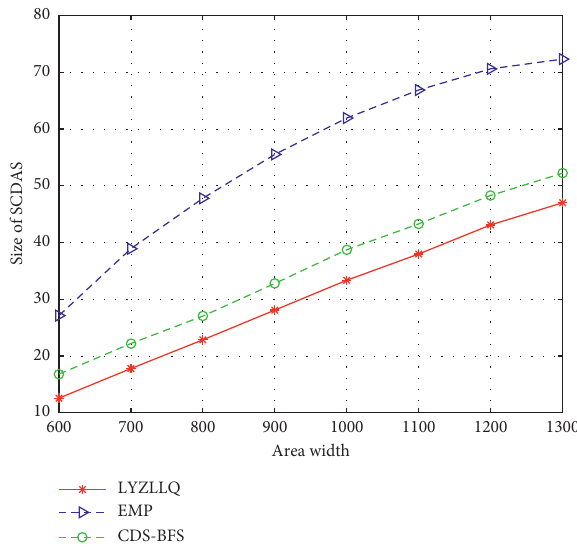
Figure 9: The impact of the network density when varying the spatial